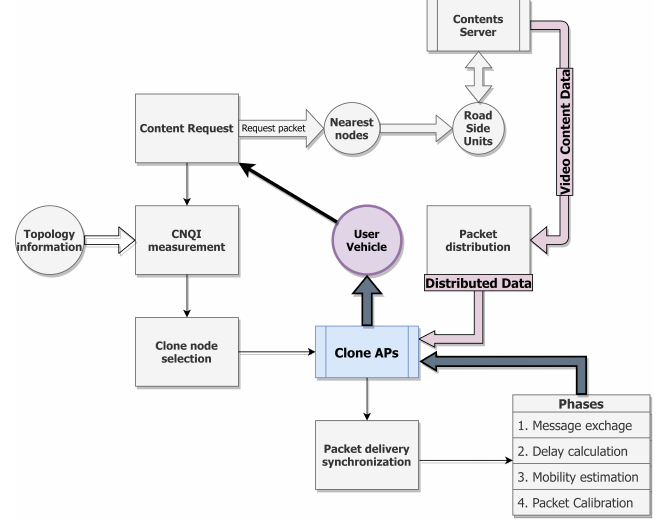
Figure 3. Flow chart of the Clone streaming